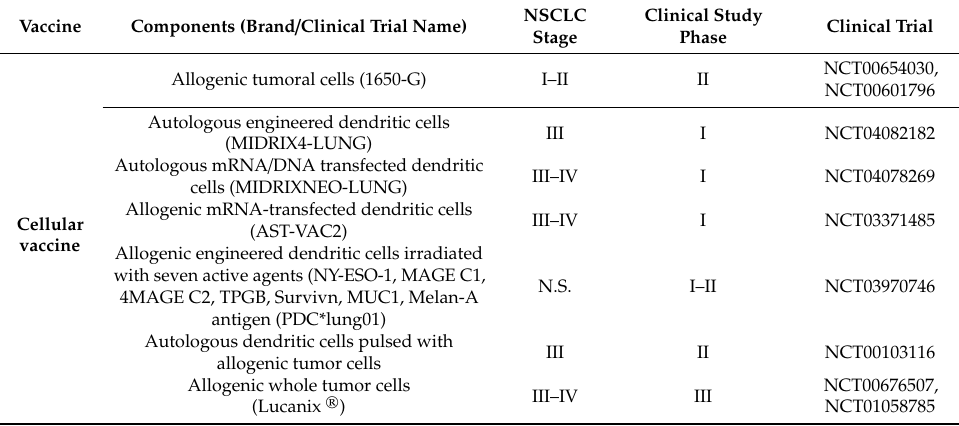
Table 6. Relevant clinical trials evaluating cancer vaccines for NSCLC. *N.S.: Not Specified